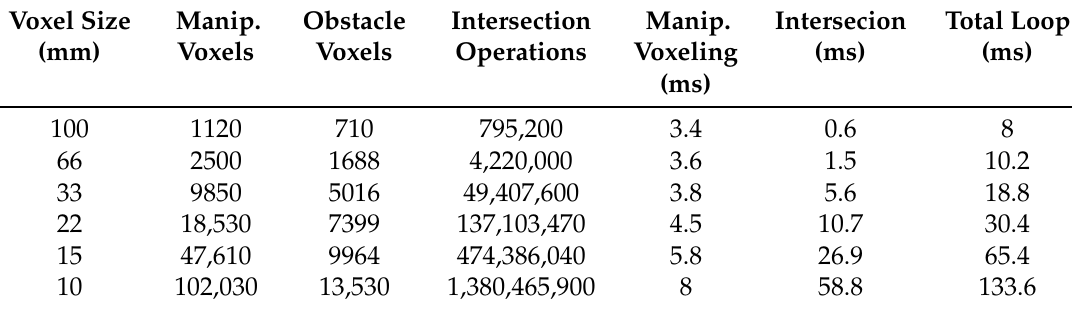
Table 1. Computational load analysis of the collision detection